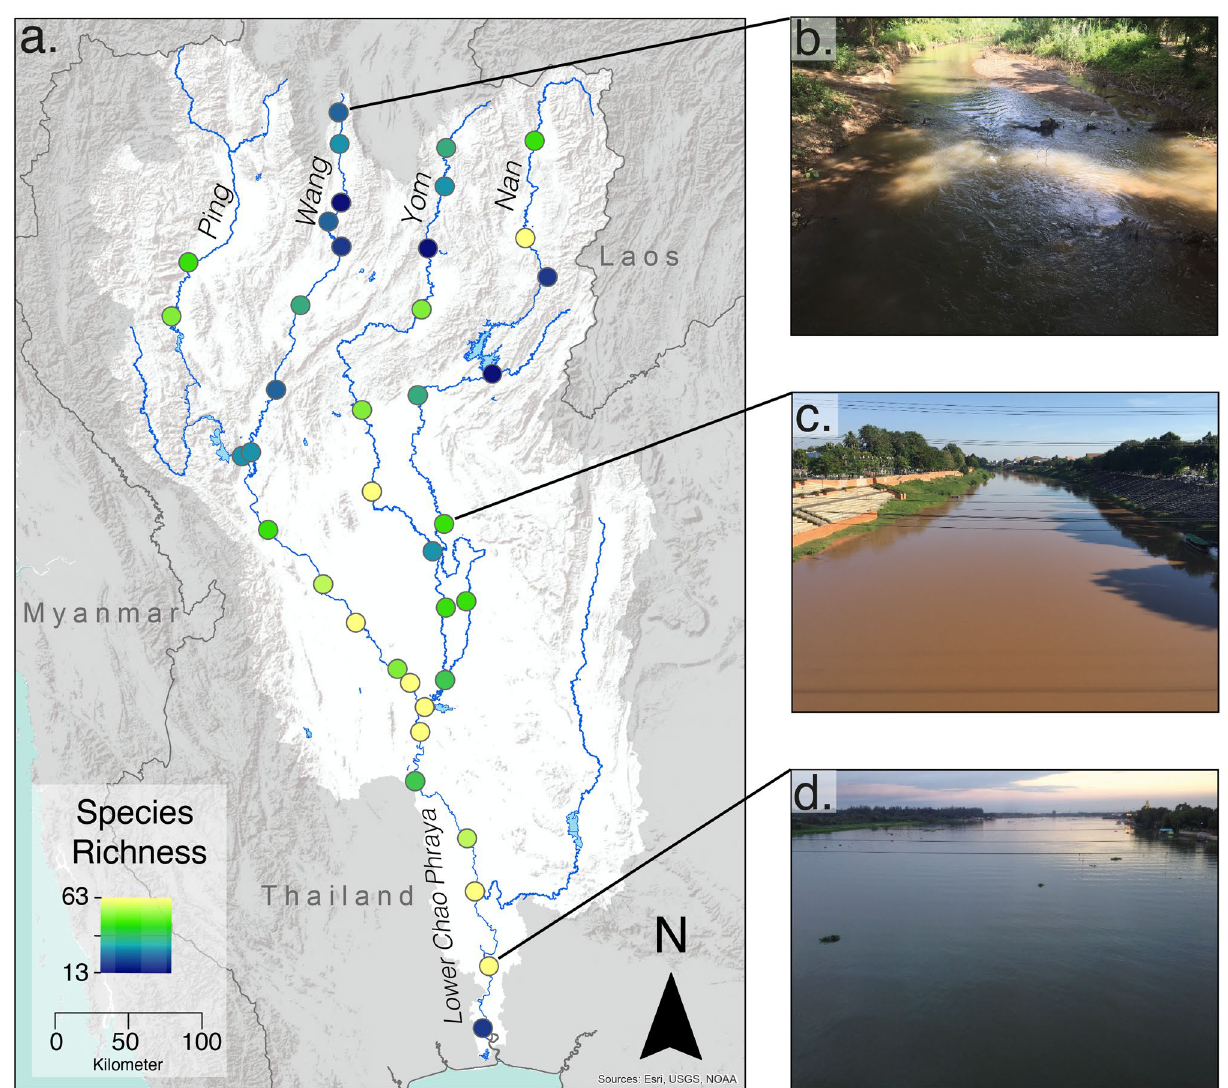
Figure 1. Local species richness of fish collected from eDNA samples in the Chao Phraya catchment and representative site illustrations. ( a ) Local species richness (α-diversity) of freshwater fish in the Chao Phraya catchment (outlined by the white background) located in Northern Thailand, ( b ) Channel photograph at a headwater stream (site 9: River Wang), ( c ) Channel photograph at a mid-order stream (site 31: River Nan), ( d ) Channel photograph at a lowland stream near Bangkok (at site 38: lower Chao Phraya river). Approximate cross-section width at these sites is 9 m, 75 m, and 250 m, respectively. The base map data was sourced from HydroSHEDS. 2015: WWF in partnership with USGS, CIAT, TNC, CESR: Esri, 2013 and mapped using ArcGIS. Photographs provided by M.